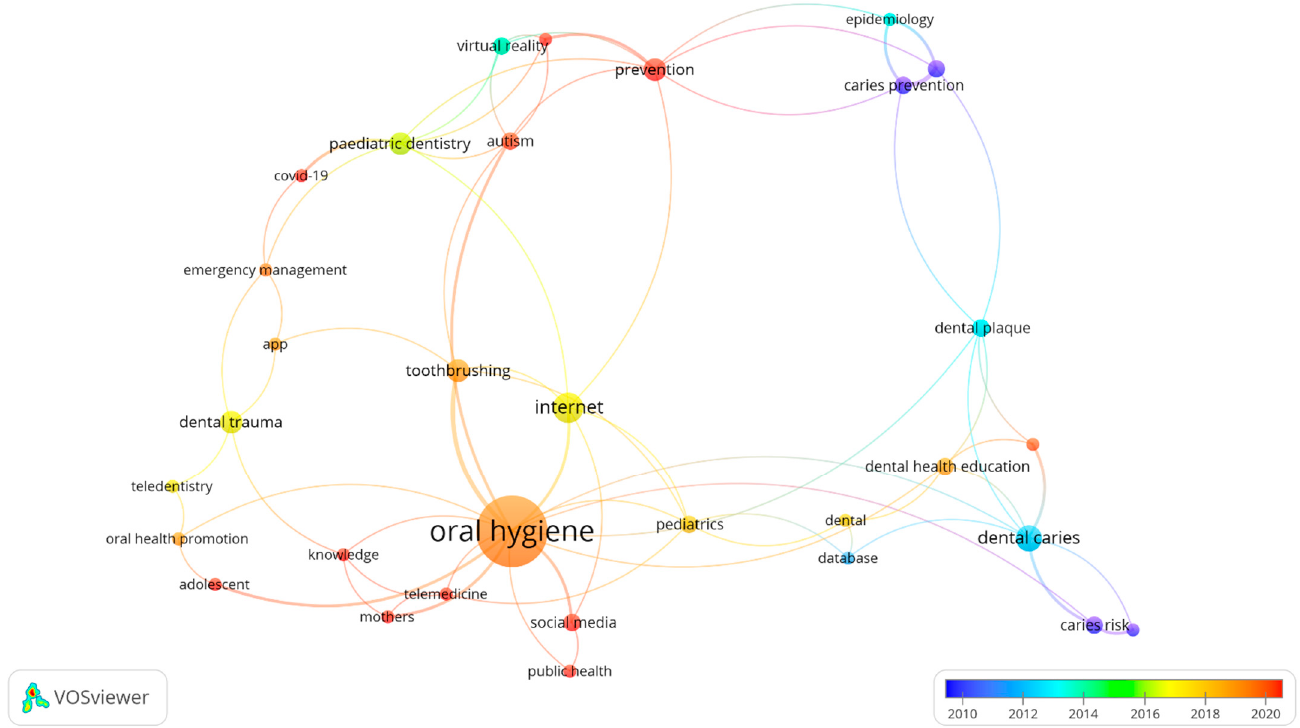
Figure 4. Overlay visualization map of the author keywords (keyword threshold = 2; displays 32 out of 211 keywords). Circles in dark and light blue and green represent those oral and dental related topics and digital technologies with an older average publication year. Circles in yellow, orange, and red demonstrate the terminologies with newer and more recent average publication year.